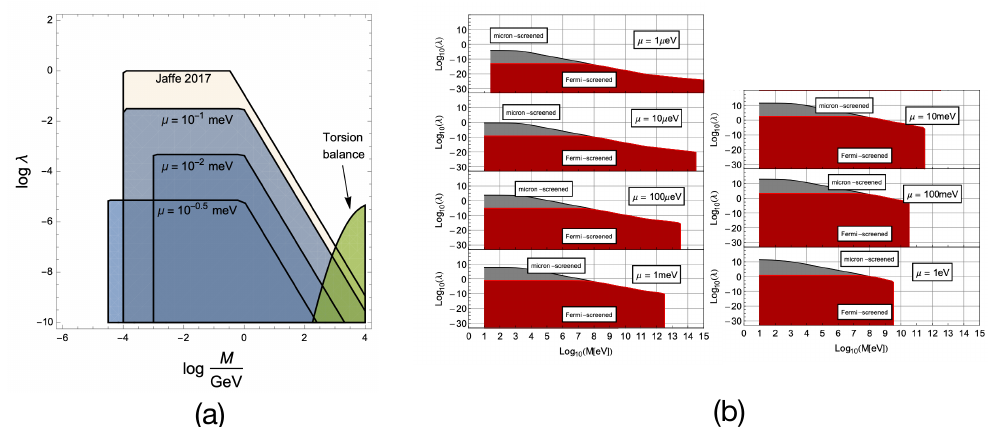
Figure 2. Current bounds on symmetron theory parameters from atom interferometry and torsion balances ( a ) and from cold bouncing neutrons ( b ). The tan curves derive from atom interferometry, while the green region is ruled out by torsion balances. Both the tan and green regions apply only to µ = 10 − 1 meV. On the right, only the red curves have been conclusively ruled out by bouncing neutrons. Reproduced from